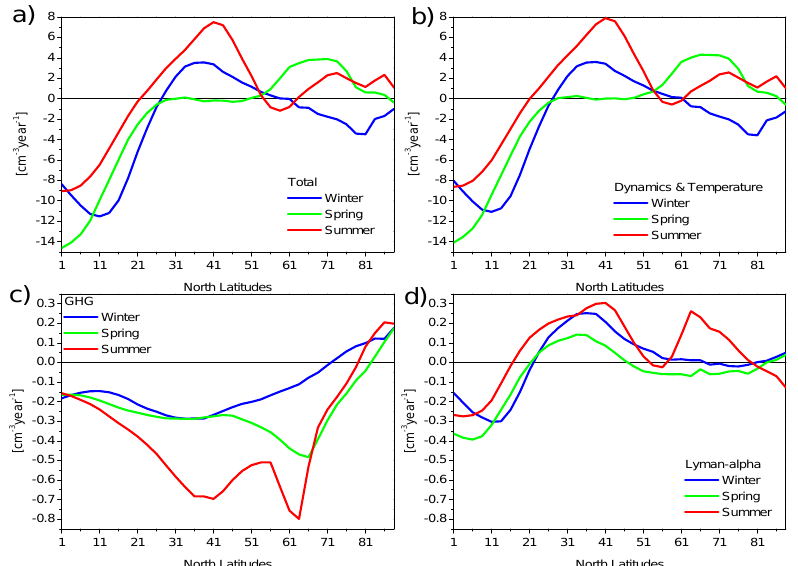
Figure 6. Trends of OH ∗ -peak number density in the Northern Hemisphere averaged over the night and season due to the total impact (a) , v = 6 dynamics and temperature (b) , growth of GHGs in the CTM (c) , and Lyman- α variability (d) for winter (blue line), spring (green line), and summer (red line). Note that the scales are different in (a) , (b) and (c) , (d) .